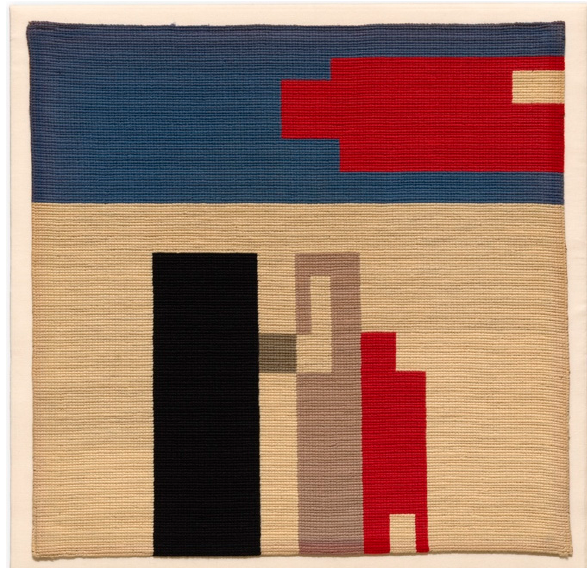
Figure 14. Sophie Taeuber-Arp, Composition pathétique à plans rectangulaires, 1928. Colored yarn. 50 cm × 50 cm. Stiftung Arp e.V., Berlin/Rolandswerth, used by permission.